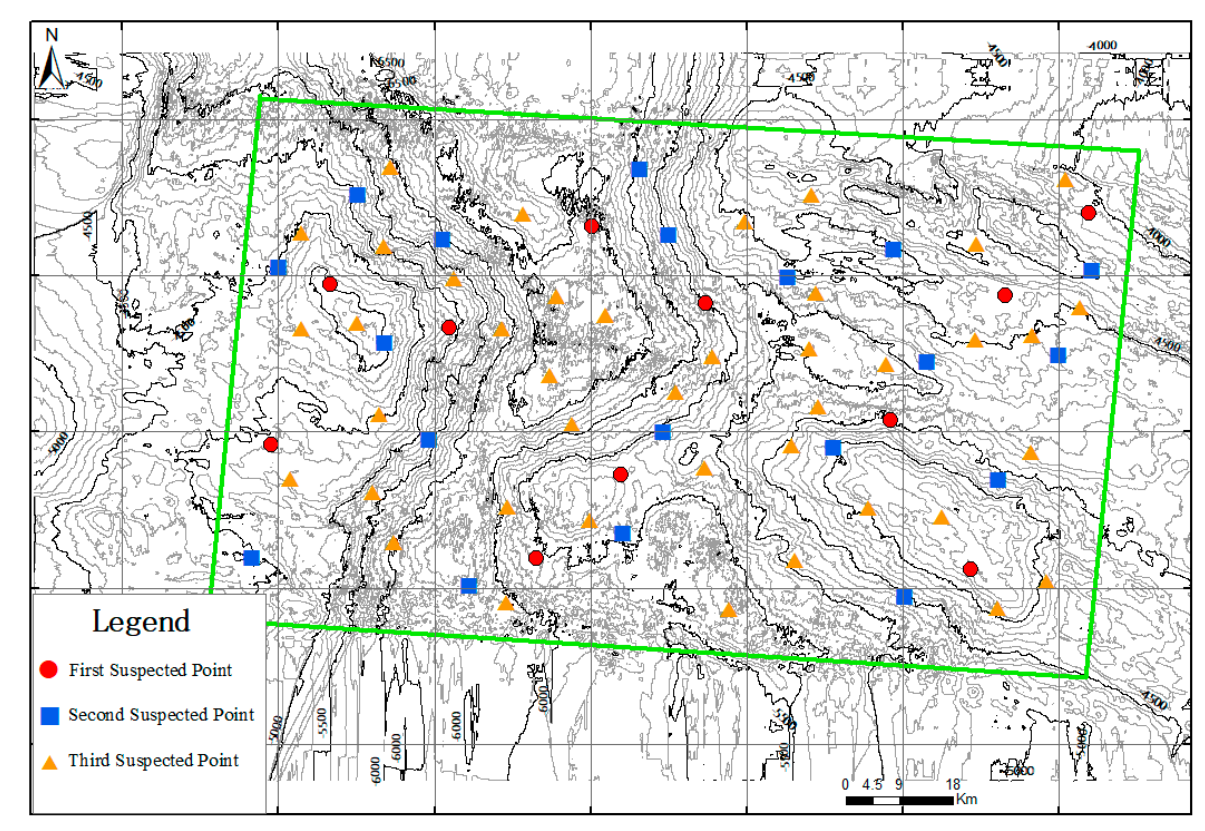
Figure 17. Operating area map. Table 1. Operational time and dive times of the three cooperative operational